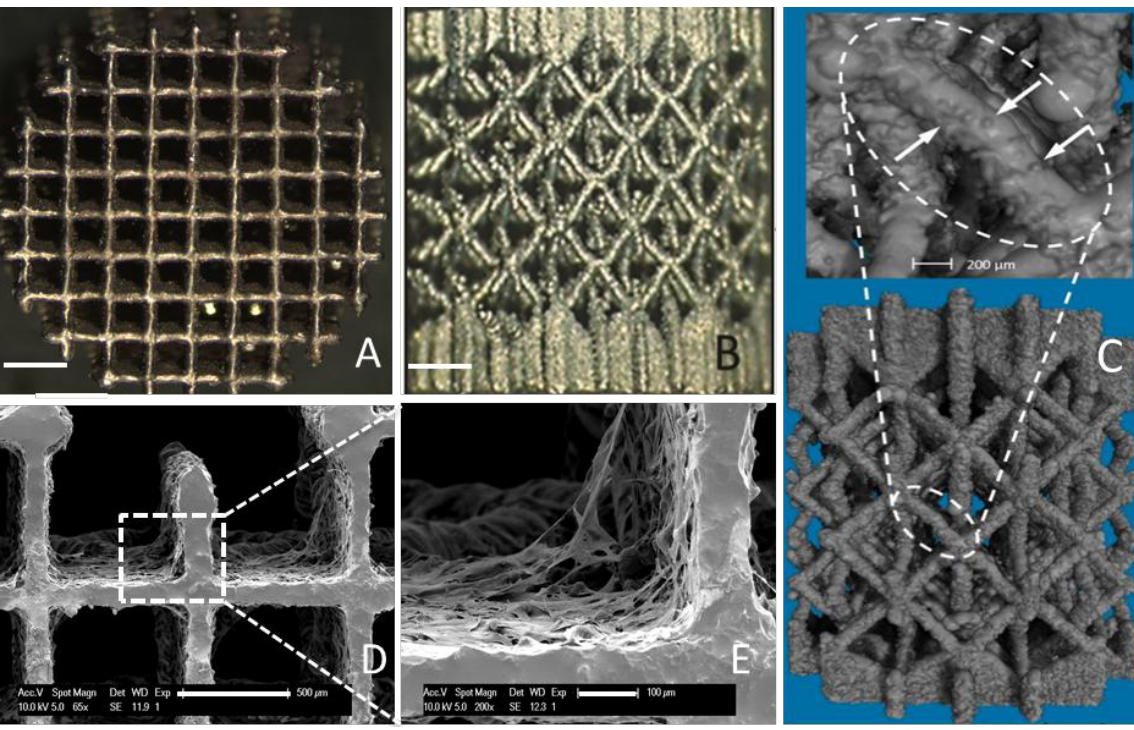
Figure 2. Ti6Al4V scaffolds used for cell seeding and subsequent cell culture: ( A ) scaffold top view ( B ) scaffold side view (scale bar ( A ) and ( B ): 1 mm); ( C ) micro-CT 3D visualization of scaffold and strut close-up from [36]; and ( D , E ) SEM images (scale bar: ( D ) 500 µm; ( E ) 100